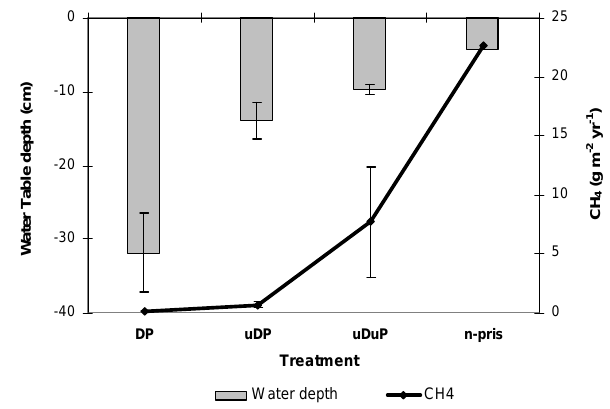
Fig. 6. Mean annual water table depth and CH 4 flux measured from Figure 6. Mean annual water table depth and CH 4 flux measured from each treatment each treatment at Flanders moss during the study period (mean at Flanders moss during the study period (mean year 1 and year 2). Bars denote year 1 and year 2). Bars denote standard error of differences be- tween the replicated standard error of differences between the replicated blocks.